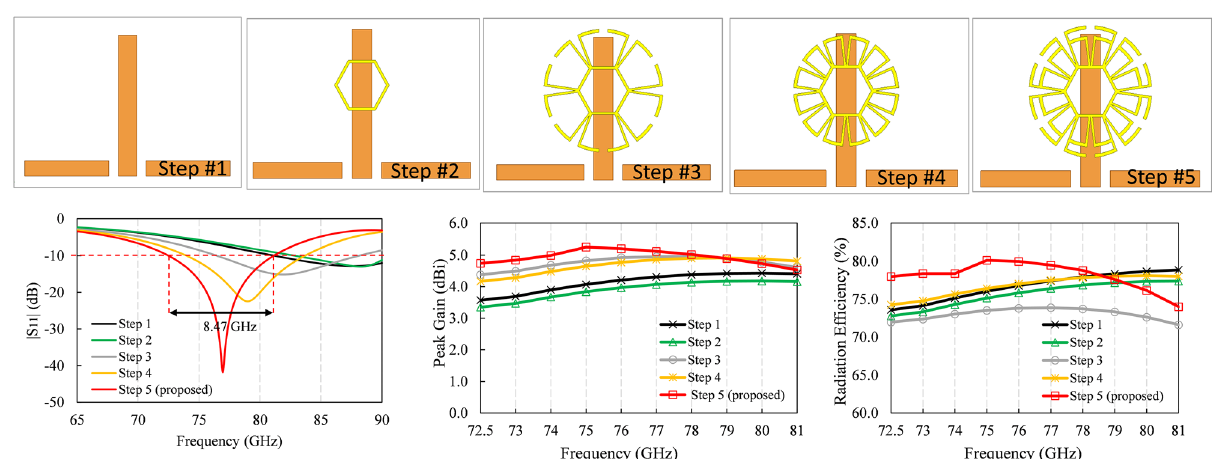
Figure 4. Operation mechanism: ( a ) magnetic coupling, ( b ) induced current, and ( c ) fields throughout the structure.